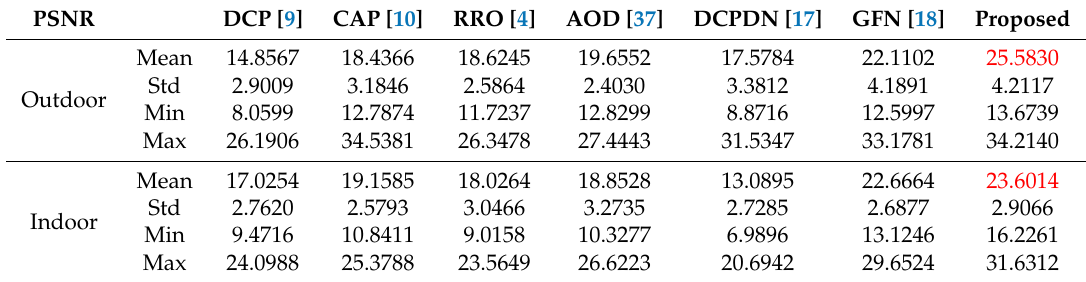
Table 6. Comparative PSNR results of dehazing methods on SOTS. Best score is marked in red.